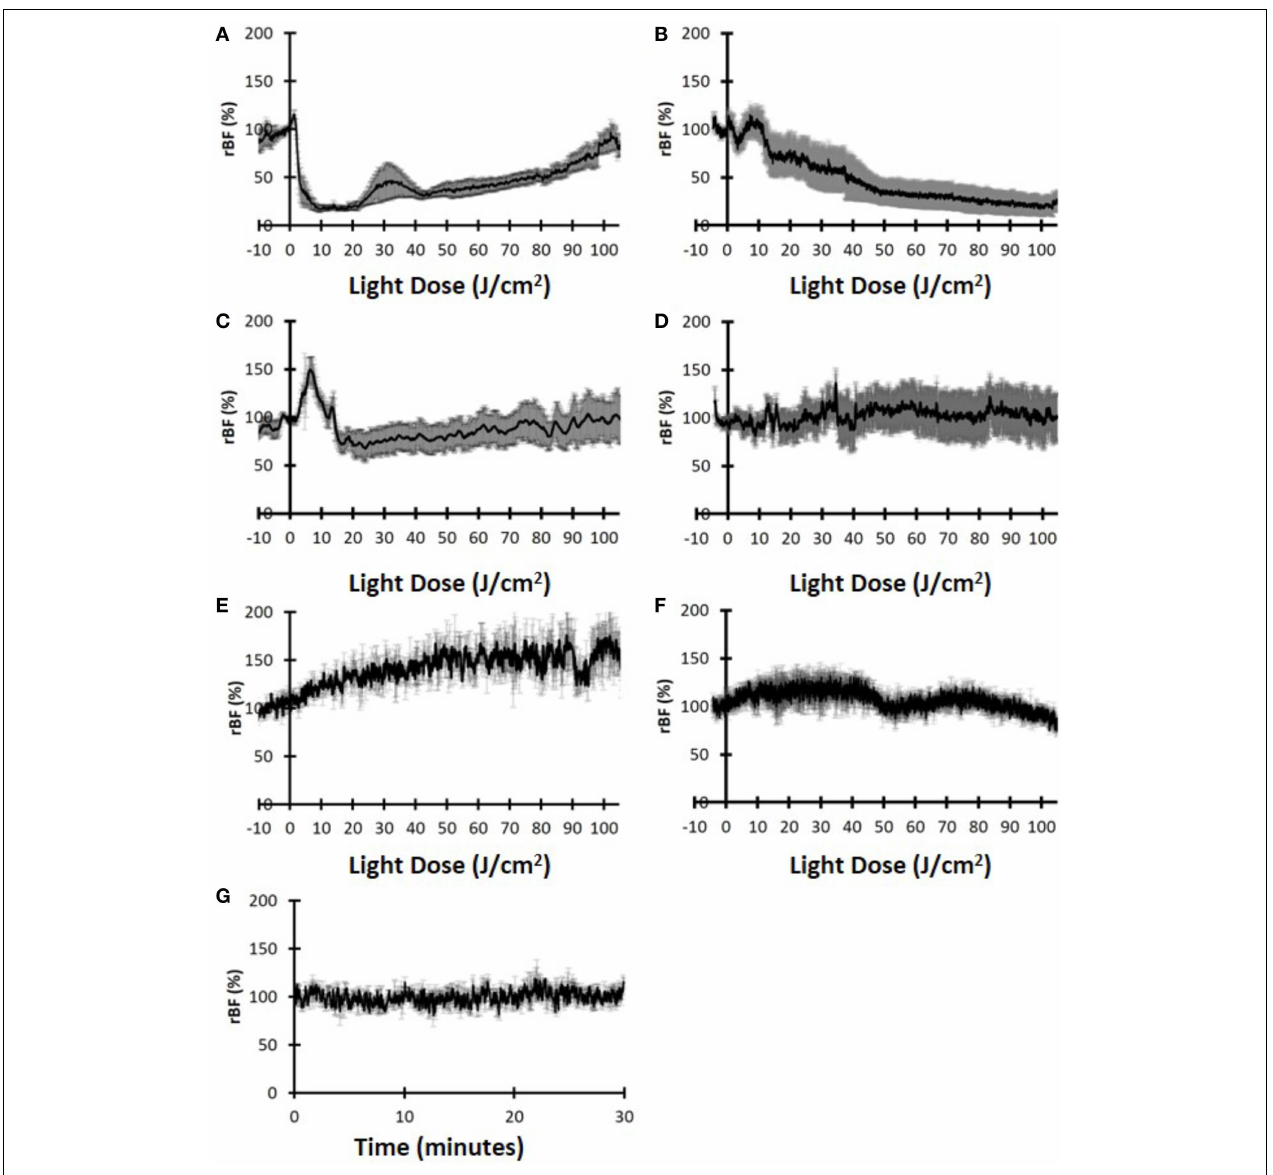
FIGURE 6 | Relative blood flow (rBF) dynamics indicate the differences for the two treatment groups. (A) Tumor rBF for mice treated with high fluence rate and (B) Tumor rBF for mice treated with the low fluence rate. (C) Hip muscle rBF for mice treated with high